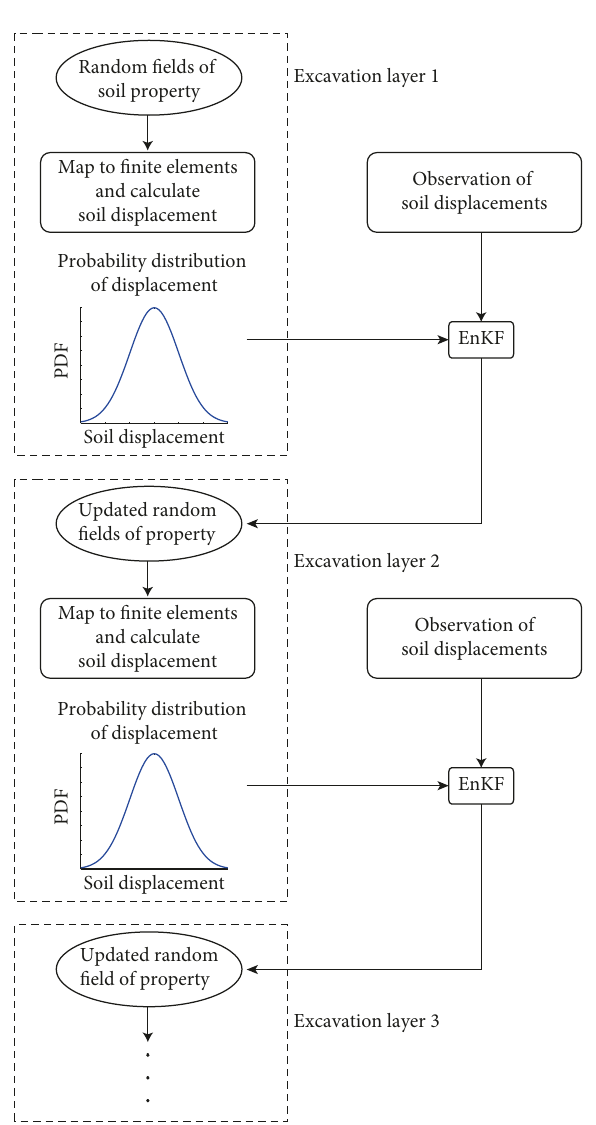
Figure 8: Flowchart of the conditional simulation via